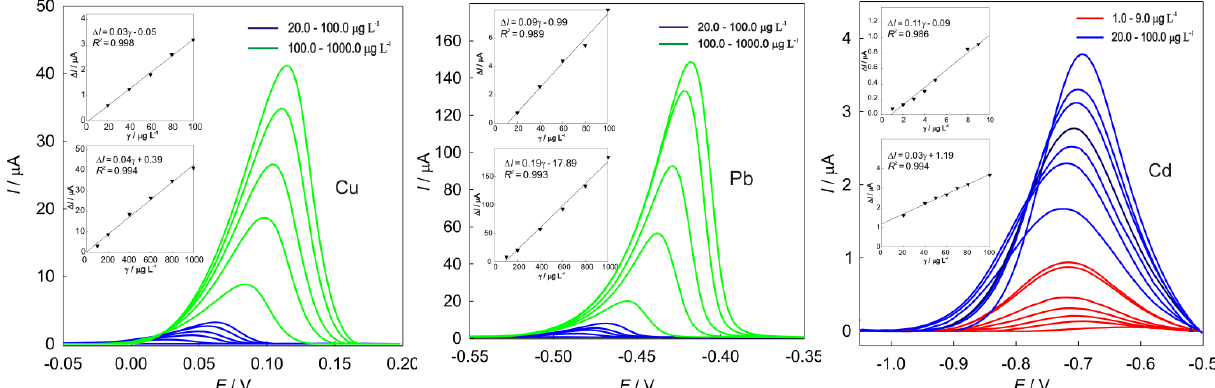
Figure 6. SWCSVs (baseline corrected), recorded at the HAp/GC electrode in 0.2 M KNO 3 (pH = 4), with corresponding calibration plots derived by subtracting the background current from the corresponding voltammograms of copper, lead, and cadmium.